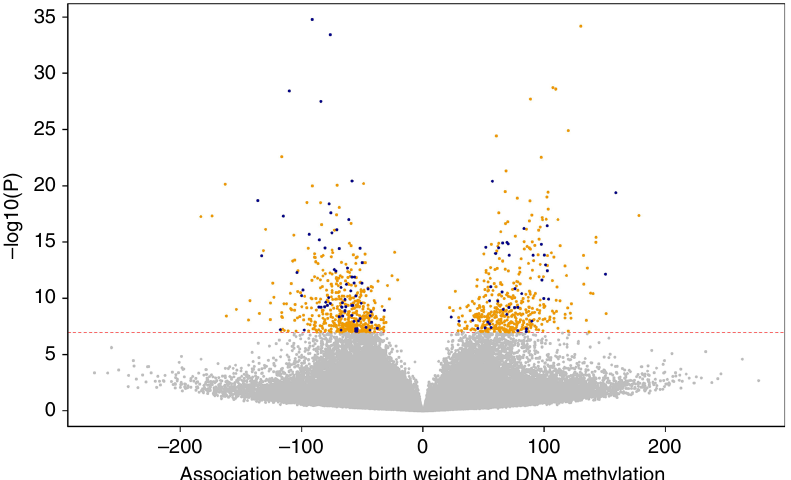
Fig. 3 Volcano plot showing the direction of associations of DNA methylation with birthweight in 8825 neonates from 24 studies. The X -axis represents the difference in birthweight in grams per 10% methylation difference, the Y -axis represents the − log 10 ( P ). The red line shows the Bonferroni-corrected signi fi cance threshold for multiple testing ( p < 1.06 × 10 − 7 ). Highlighted in orange are the 914 CpGs with p < 1.06 × 10 − 7 and I 2 ≤ 50% and highlighted in blue are the 115 CpGs with p < 1.06 × 10 − 7 and I 2 >